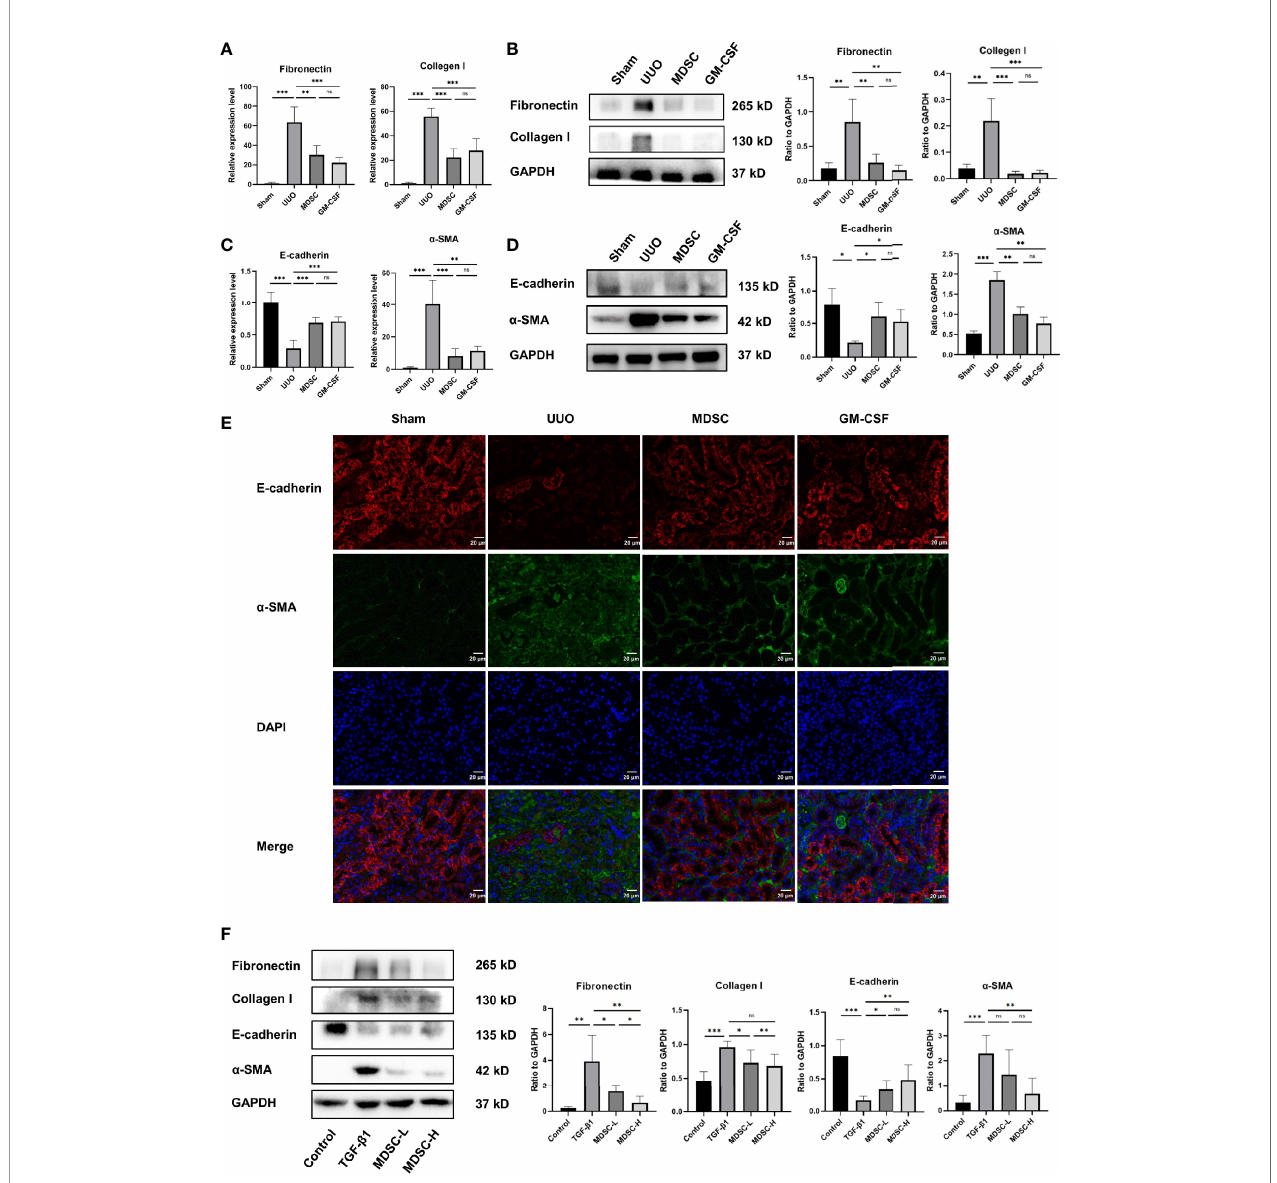
FIGURE 2 | BM-induced MDSCs and GM-CSF reduce ECM deposition and EMT. (A) Relative mRNA levels of fi bronectin and collagen I in renal tissue. (B) Western blot analysis of fi bronectin and collagen I in renal tissue and their relative expression level to GAPDH. (C) Relative mRNA levels of E-cadherin and a -SMA in renal tissue. (D) Western blot analysis of E-cadherin and a -SMA in renal tissue and their relative expression level to GAPDH. (E) Representative immuno fl uorescence staining images of E-cadherin (red), a -SMA (green), and DAPI (blue). (F) Western blot analysis of fi bronectin, collagen I, E-cadherin, and a -SMA in in vitro experiment and their relative expression level to GAPDH. Data are presented as the mean ± SD (n = 6). * p < 0.05, ** p < 0.01, *** p < 0.001. ns^P >